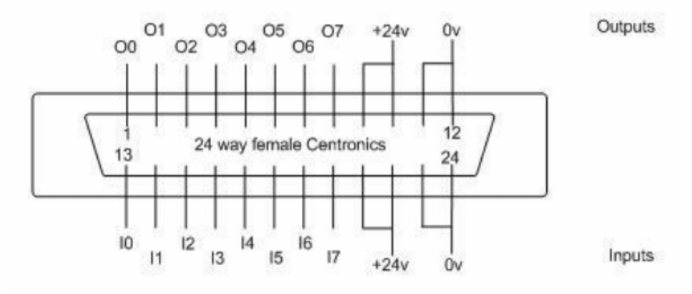
Figure 14. Physical pin connections of the Centronics